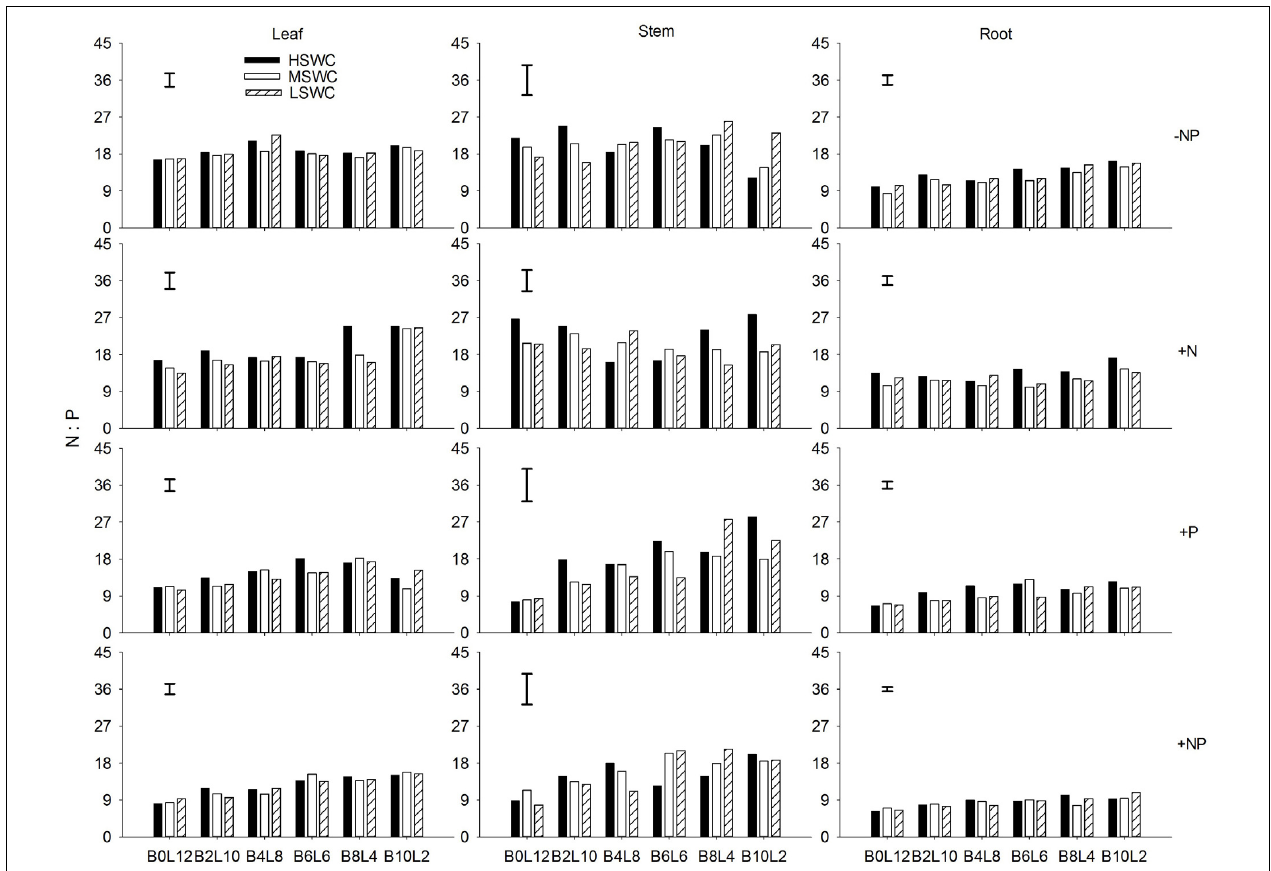
FIGURE 3 | Leaf, stem, and root N:P ratios of L. davurica (L) mixed with B. ischaemum (B) at various mixture proportions under three soil water regimes [HSWC: 80% FC (field capacity); MSWC: 60% FC; LSWC: 40% FC] and four fertilization treatments (–NP, +N, +P, +NP). B i L j ( i , j = 0, 2, 4, 6, 8, 10, 12; i + j = 12) means the plant numbers of B. ischaemum to L. davurica in their mixtures. Error bars are LSD ( p <